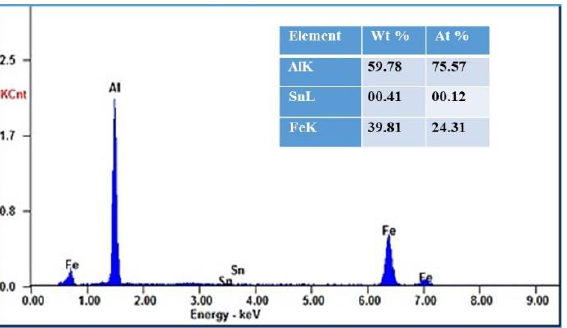
Figure 10. EDS spectra and elements analysis of points 1 marked in Figure 9a.